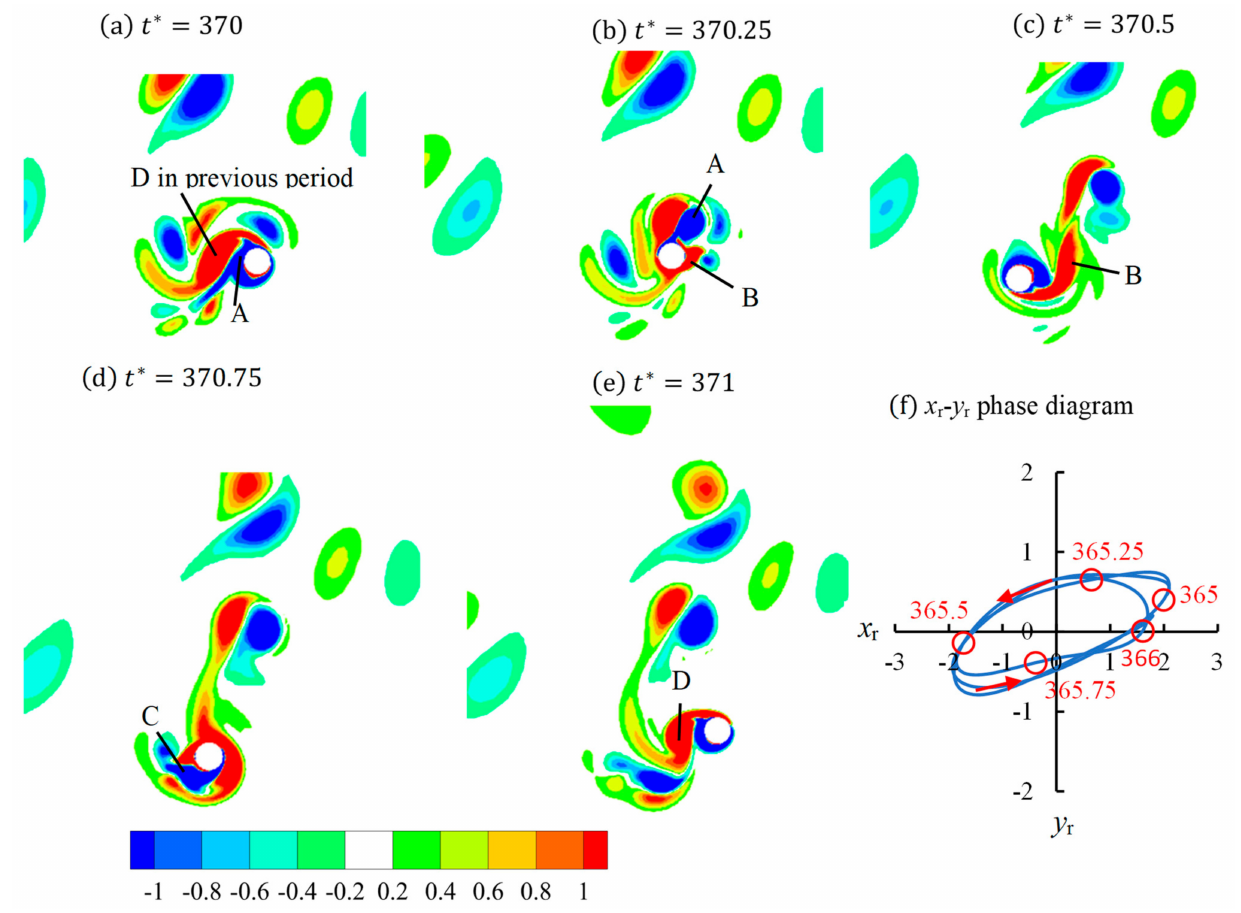
Figure 8. Regime D/F at β = 45 ◦ , KC =10, f ∗ = 0.6 within one period starting from t ∗ = 370.